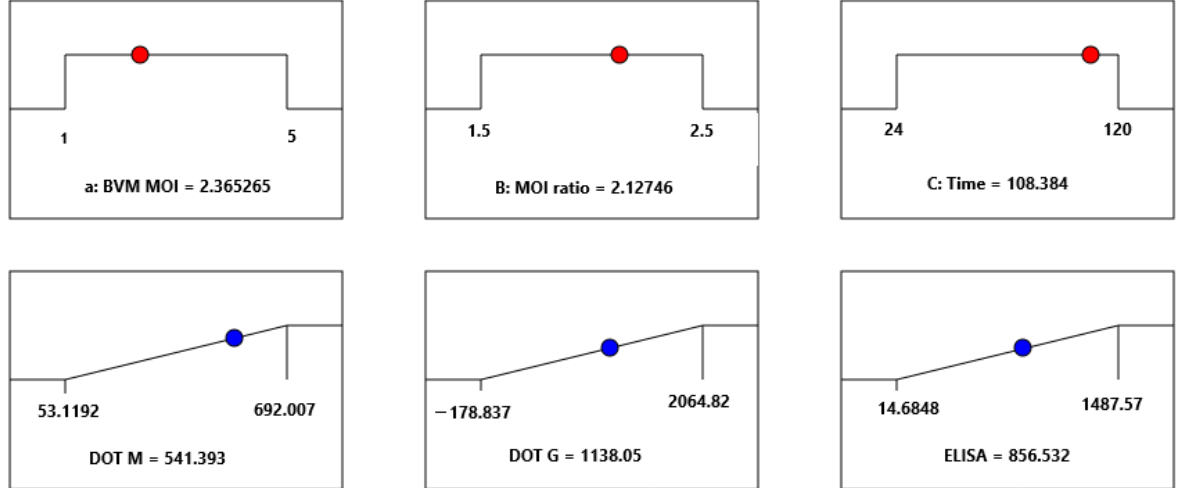
Figure 5. Ramp plots depicting the optimal solution that best satisfies the conditions described in Table 2. This solution was determined by the desirability function implemented in Design Expert ® version 13 software.